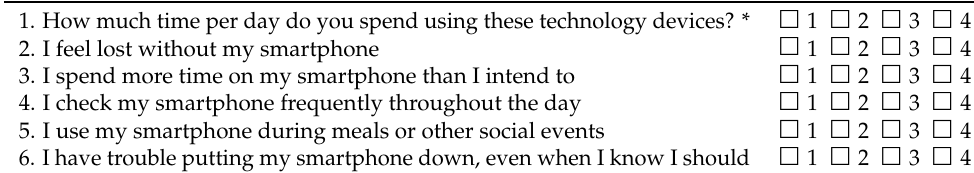
Table 1. Smartphone Use Questionnaire adapted for auto evaluation.